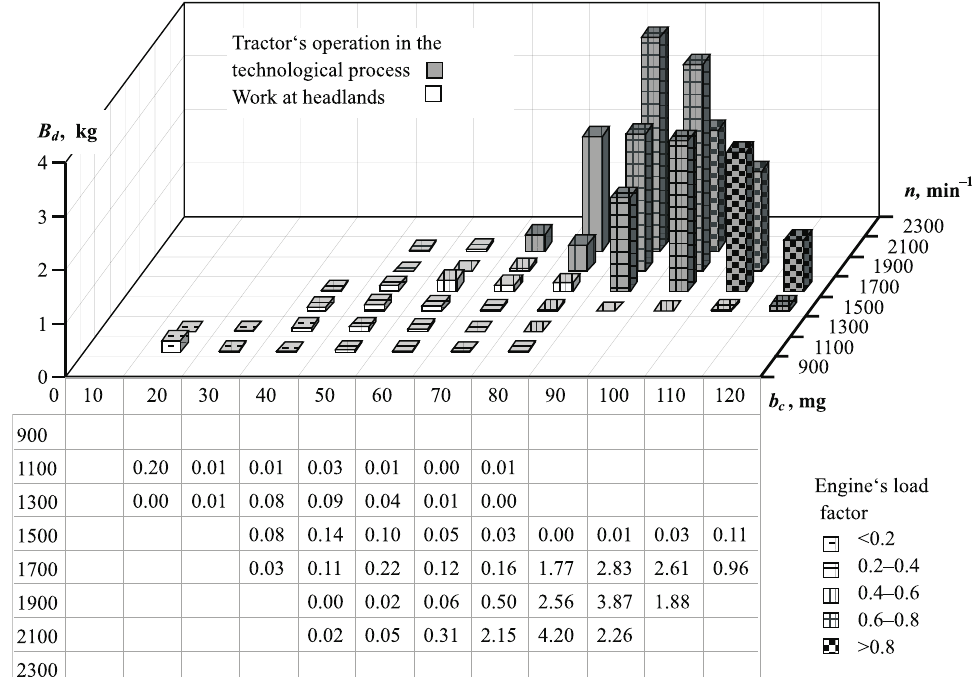
Fig. 8. Distribution of unit’s fuel consumption during the test period (3867 s) in the modes of engine speed ( n ) and cyclic fuel injection quantity ( b